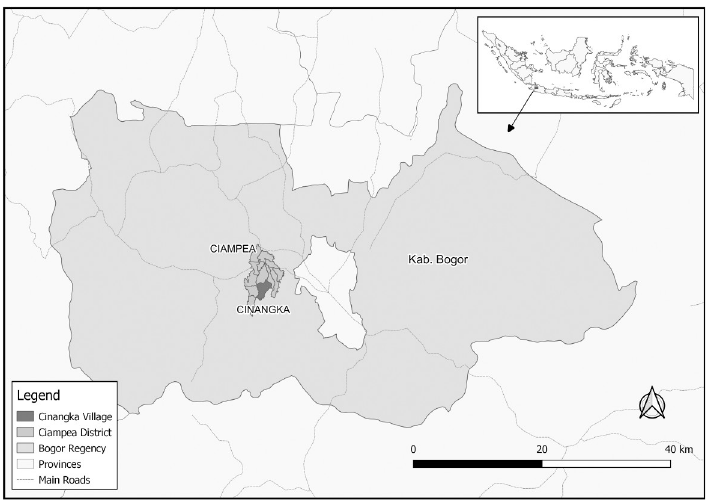
Fig 1. Sketch’s map depicting the location of the study site (Cinangka Village) in Bogor Regency and the Indonesia archipelago (https://www.naturalearthdata.com/).